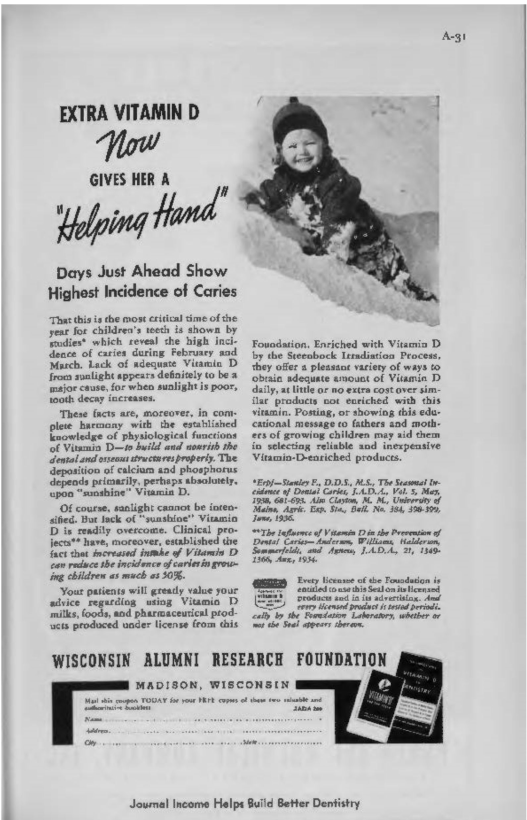
Figure 4. This advertisement appeared in JADA [114], suggested seasonality of dental caries, and provided a reference to a study supporting such a claim. Over 10 such seasonality studies had been conducted [115–125]. The National Research Council later concluded that seasonality of dental caries “merits further intensive investigation” [126]. Yet, a dental ADA CDT member reported how he had “never seen such evidence”